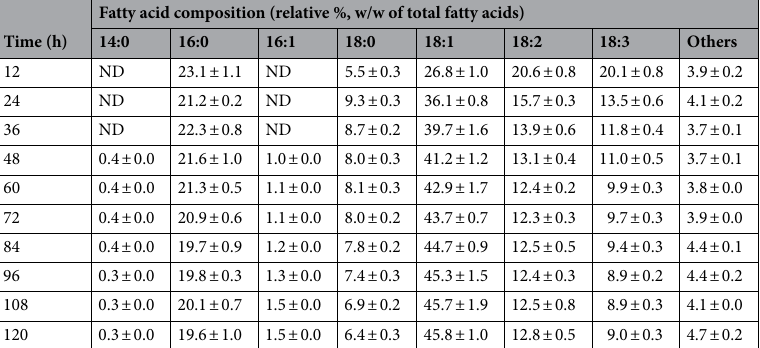
Table 1. The fatty acid composition of Mc-MT-2 in fed-batch culture. Strain was cultured in a 3 L fermenter with a glucose feeding and supplementation of malic acid at 30 °C with stirring at 500 rpm and aeration at 0.5 v/v min -1 for 120 h. The fatty acid composition was displayed at different point times. The values are means ± standard deviations of two independent experiments. ND: not